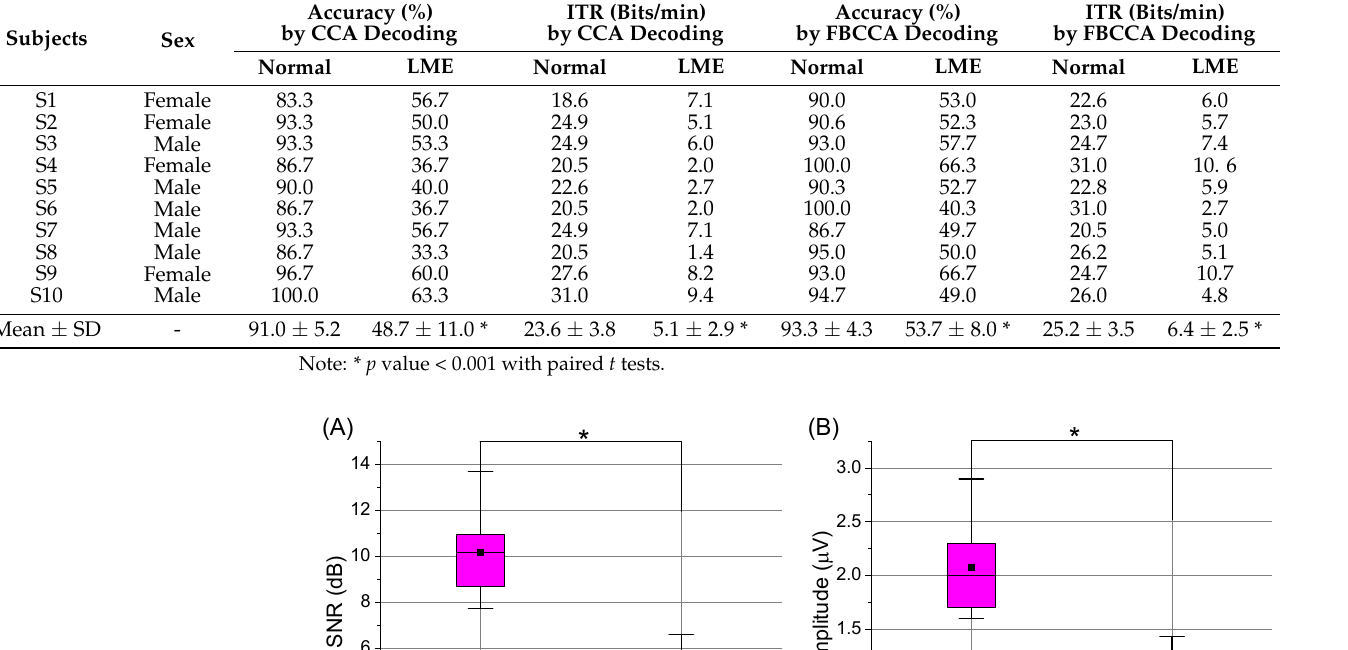
Table 2. Accuracy and ITR with the SSVEP-based BCI.